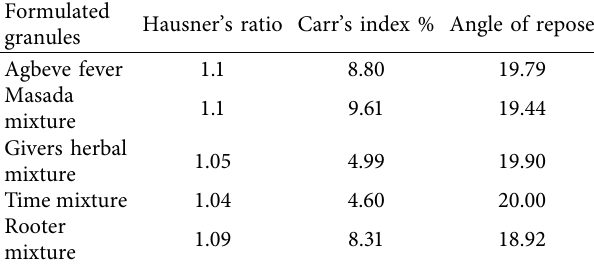
Table 2: Flow properties of Agbeve, Masada, Givers, Time, and Rooter granules.